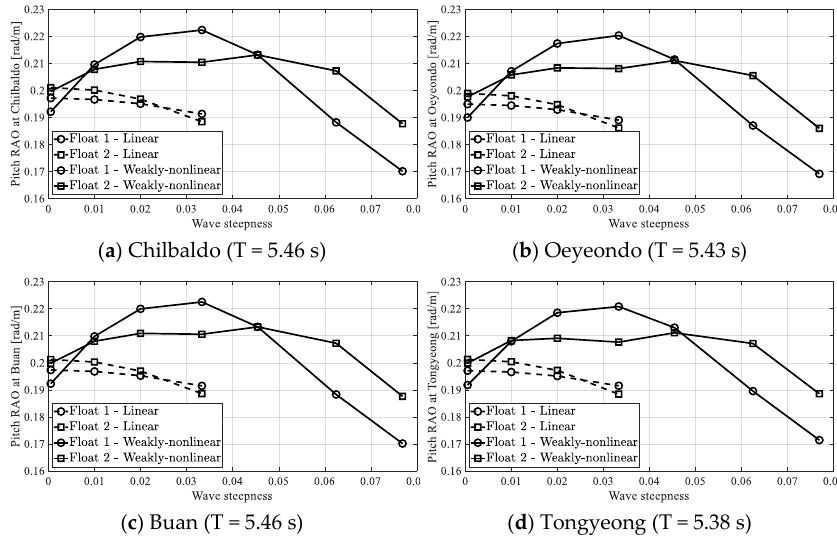
Figure 15. Comparison of the Pitch RAO assessed using linear and weakly-nonlinear analysis according to the wave steepness.